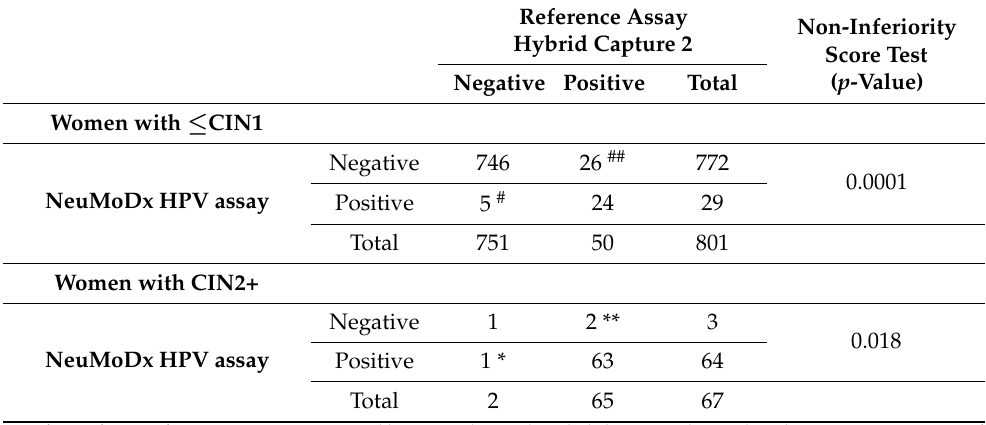
Table 1. Clinical performance for CIN2+ of NeuMoDx HPV assay as compared to Hybrid Capture 2 reference test on PreservCyt collection medium (group